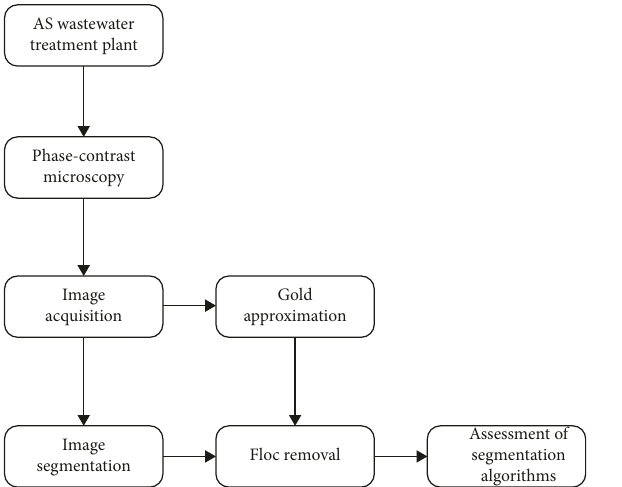
Figure 1: Diagram segmenting and assessing bright-field images activated sludge (AS).